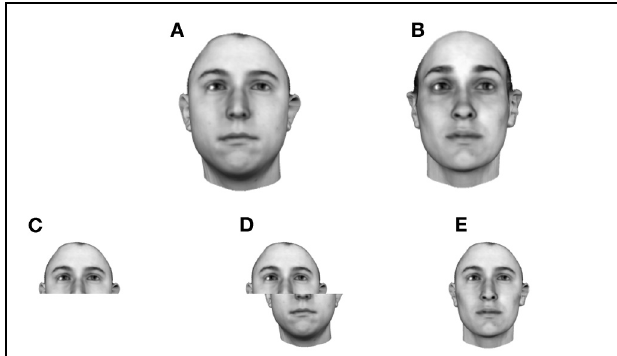
corresponding to same-race faces is, by contrast, much more densely packed and neural regions of selection heavily overlap, suggesting that other, higher dimensions play an important role in determining which neuron dominates for each input. Note that face 5 was the only other-race face to be included in a branch of the dendrogram selective primarily for own race faces. The reason becomes apparat from this figure in that face 5 lies on the boundary between own and other-race faces. (B) The same output data projected onto components three and four.